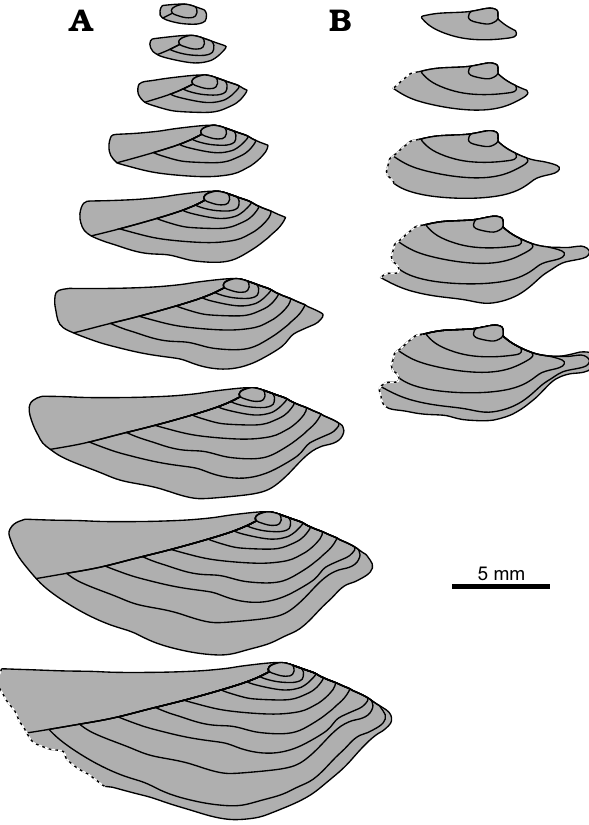
Fig. 8. Ontogenetic series of the pachydomid bivalve Leinzia sp. (sensu lato) from the Serrinha Member, Rio do Rasto Formation after Runnegar and Newell (1971: fig. 24). Sketches based on external comarginal ornamenta- tion (rugae and growth lines) of individual shells. A, B, based on Runnegar and Newell 1971: fig. 24j, f, respectively. Note the differences in the shell shape of both specimens and those illustrated in Fig. 9; also, note the ubiqui- tous rostrum in the specimen in Fig. 9B.